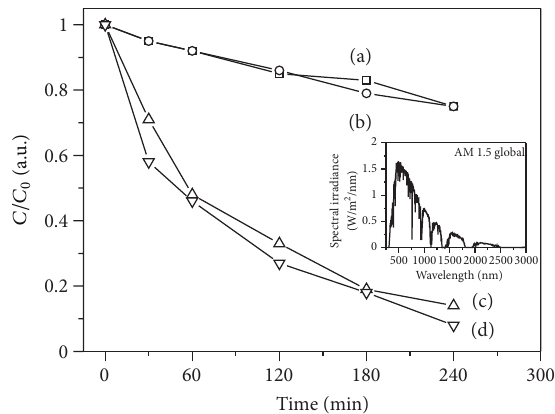
Figure 4: Photocatalytic degradation of methylene blue on the (a) nanosize TiO 2 , (b) TNT, (c) Cu-TNT, and (d) Fe-TNT under sunlight illumination (AM 1.5 G). The inset shows the spectrum of the sunlight source.